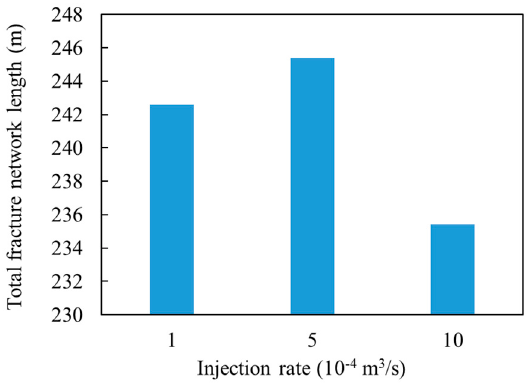
Figure 13. Fracture network lengths at different injection rates.